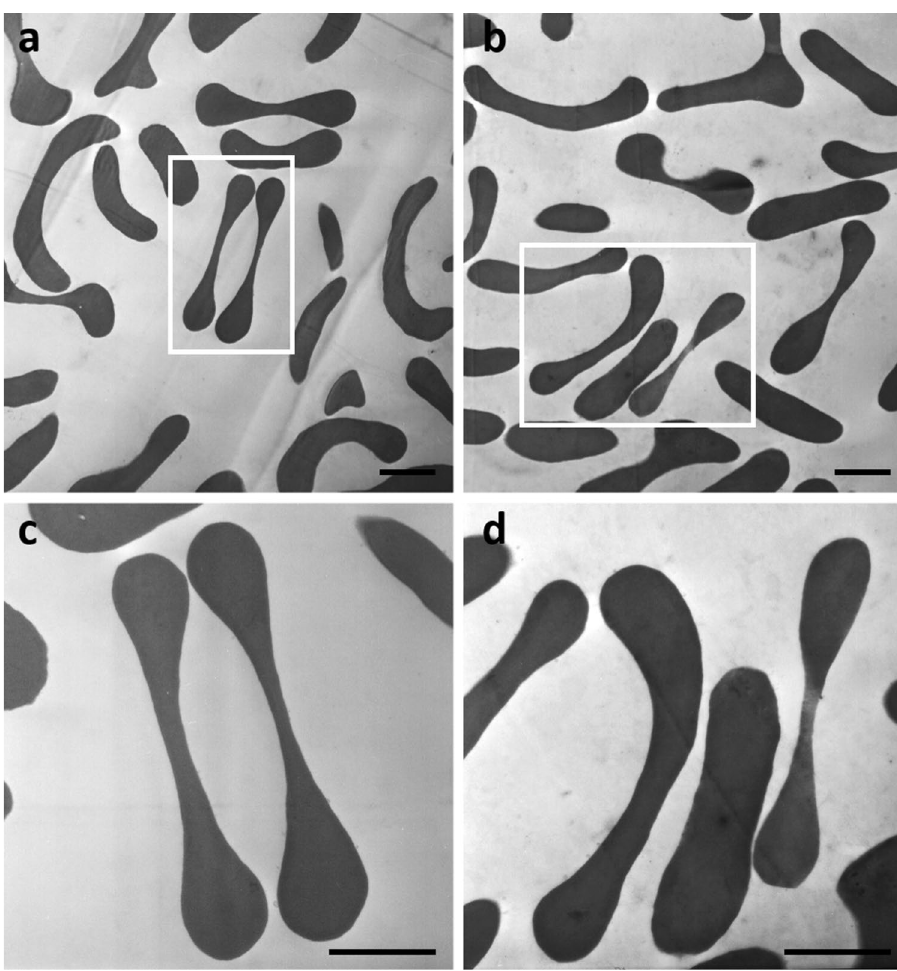
Figure 2. Representative transmission electron microscopy images of obese pediatric patients ( a – c ) and healthy controls ( b – d ) erythrocytes. In both situations the erythrocytes shape and membranes are well preserved and intracellular membrane vesicles are not detectable. Upper and lower panels scale bar = 1